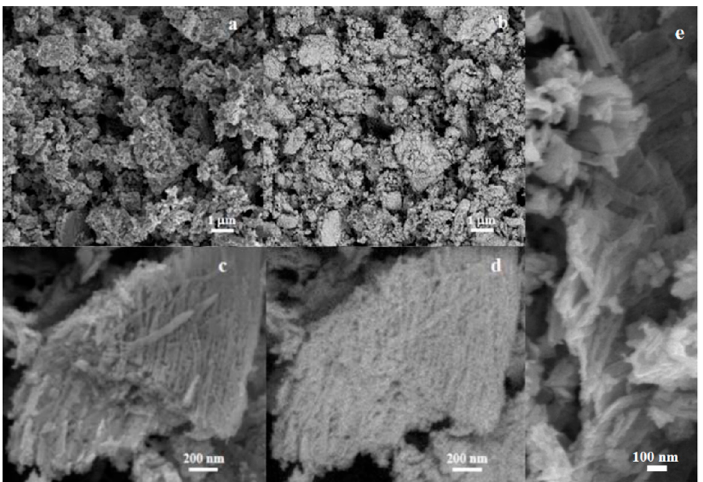
Figure 4. SEM micrographs of CuW2: ( a ) Secondary emission (SE) and ( b ) back-scattered electrons (BSE) images taken simultaneously from the same region and higher resolution, ( c ) SE, ( d ) BSE micrographs, and ( e ) higher magnification images.